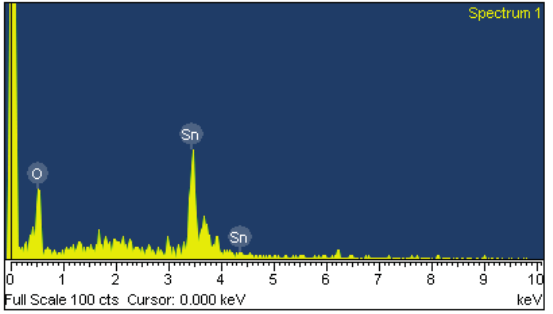
Figure 5. Elements of the tin dioxide film measured by EDS.